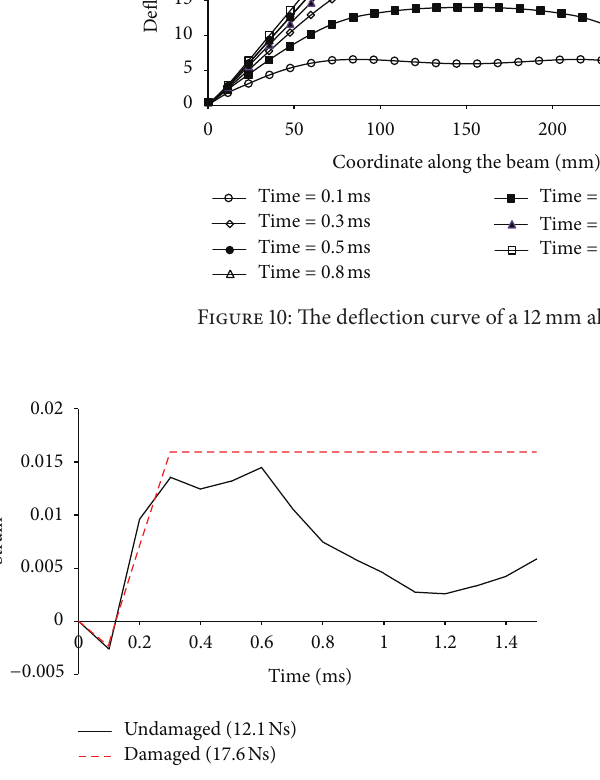
Figure 11: The strain evolution of the CFRP element at mid-span subjected to different impulses.